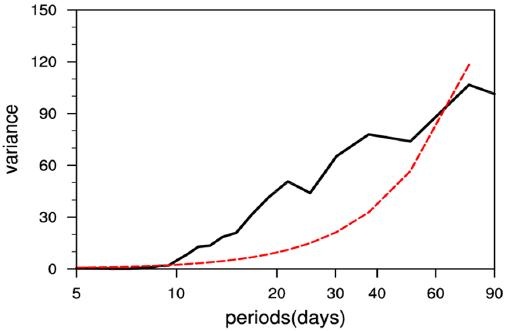
Figure 3. Winter mean power spectra of daily T min in the southern region (20°–30° N, 105°–122.5° E) during 1979–2019. (The red line represents the 95% significant level of red noise spectrum.)